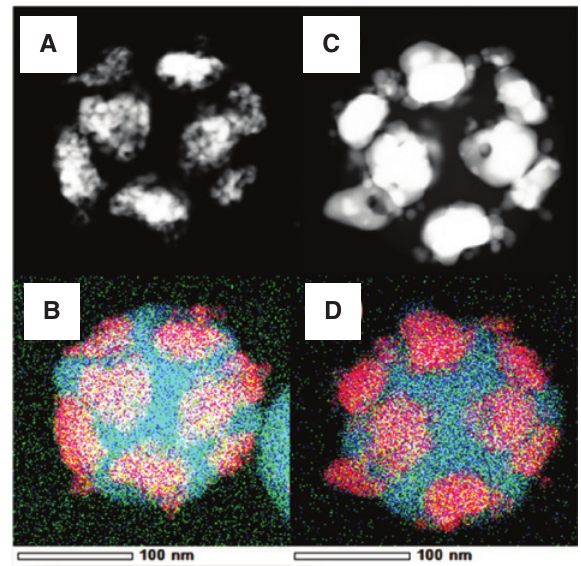
(A and C) SEM of dodecapods S1 before (A) and after (C) condensation and (B and D) elemental analysis revealing silica (blue) and gold (red). Images (A and B) and (C and D) correspond to samples S3-NC and S3-C, respectively (see